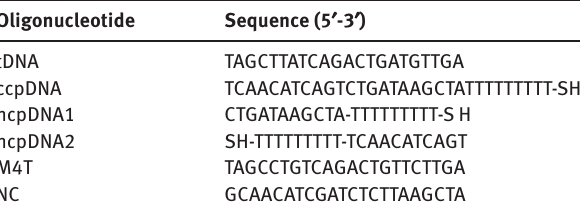
Table 1: The oligonucleotide sequences used in this study.